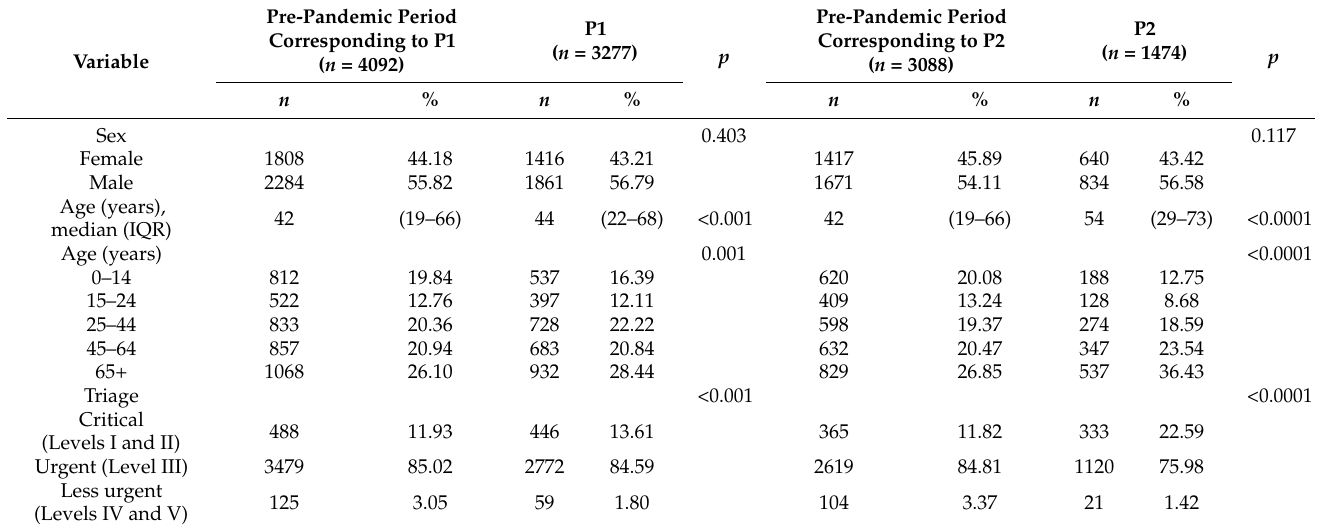
Table 2. Comparison of the TBI sample characteristics before and after the COVID-19 pandemic.